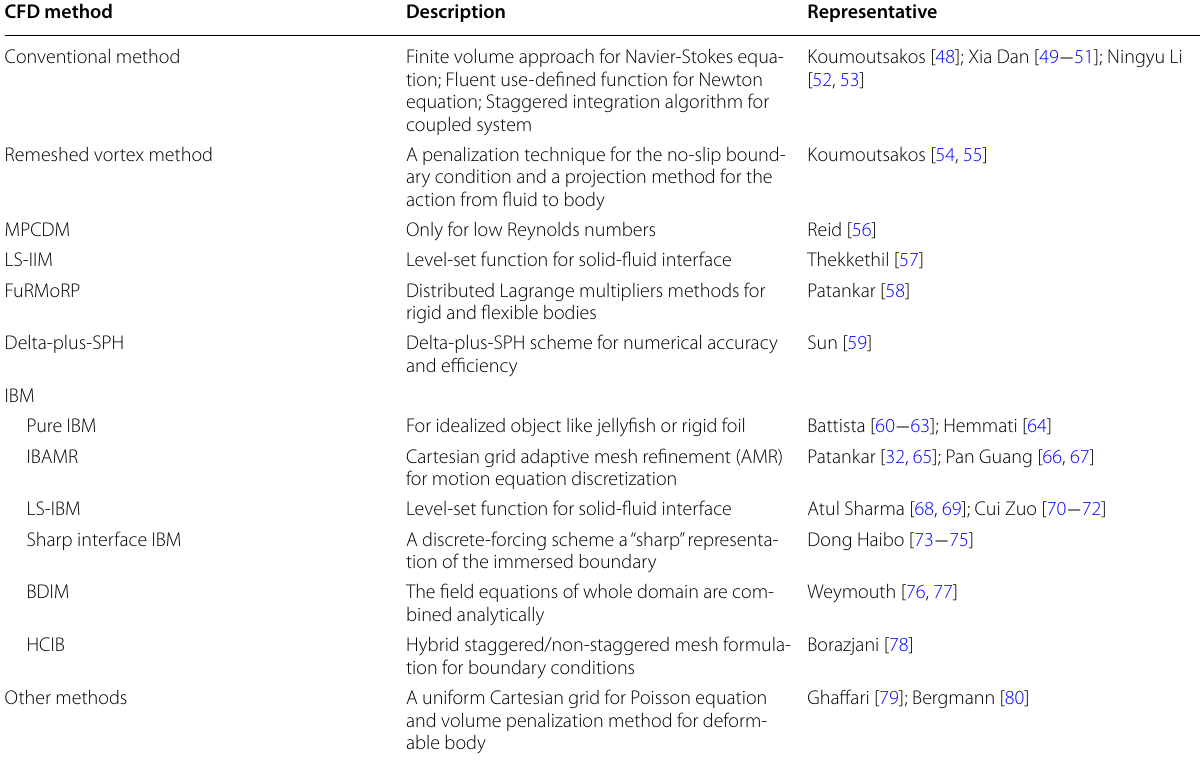
Note: HCIB: Hybrid Cartesian/immersed boundary method; LS-IIM: A level-set function based immersed interface method; FuRMoRP: Fully resolved momentum redistribution for self-Propulsion algorithm; BDIM: Boundary Data Immersion Method; MPCDM: Multiparticle collision dynamics model.